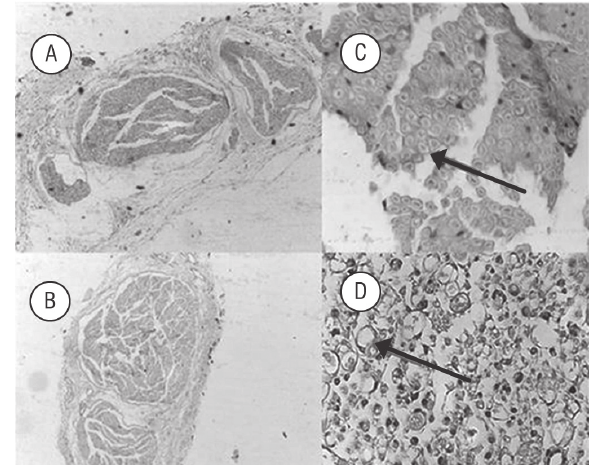
Figura 6 - Fotomicrografias de cotos distais e proximais de animais sedentários e exercitados. A) vista panorâmica do coto proximal do nervo ciático do grupo exercitado durante 21 dias; B) vista pano- râmica do coto distal à lesão do grupo sedentá- rio; C) porção proximal do nervo; seta indicando axônio mielinizado em animal sedentário; D)